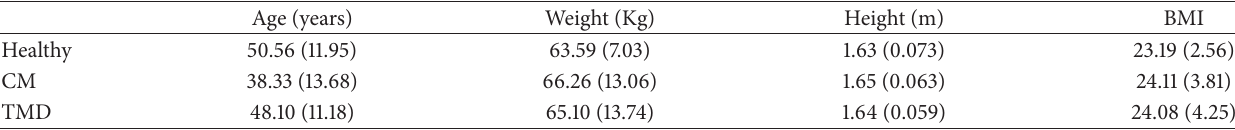
Table 1: Demographic characteristics for the